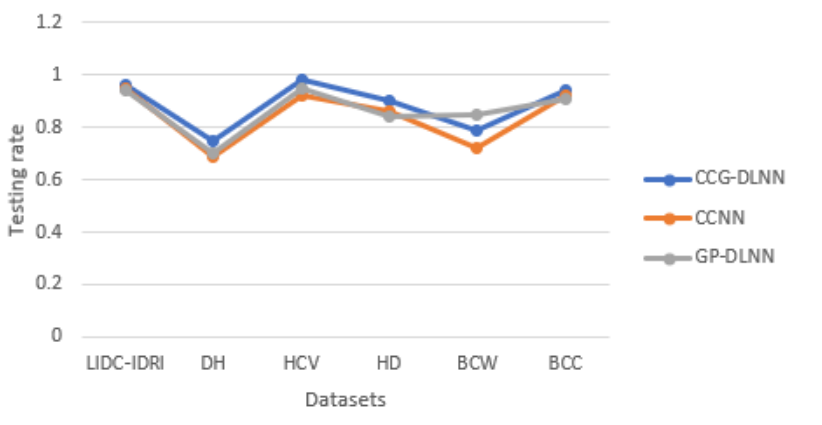
Figure 10. Curves of testing rate obtained by CCG-DLNN, GP-DLNN and CCNN on real-world classification problems.